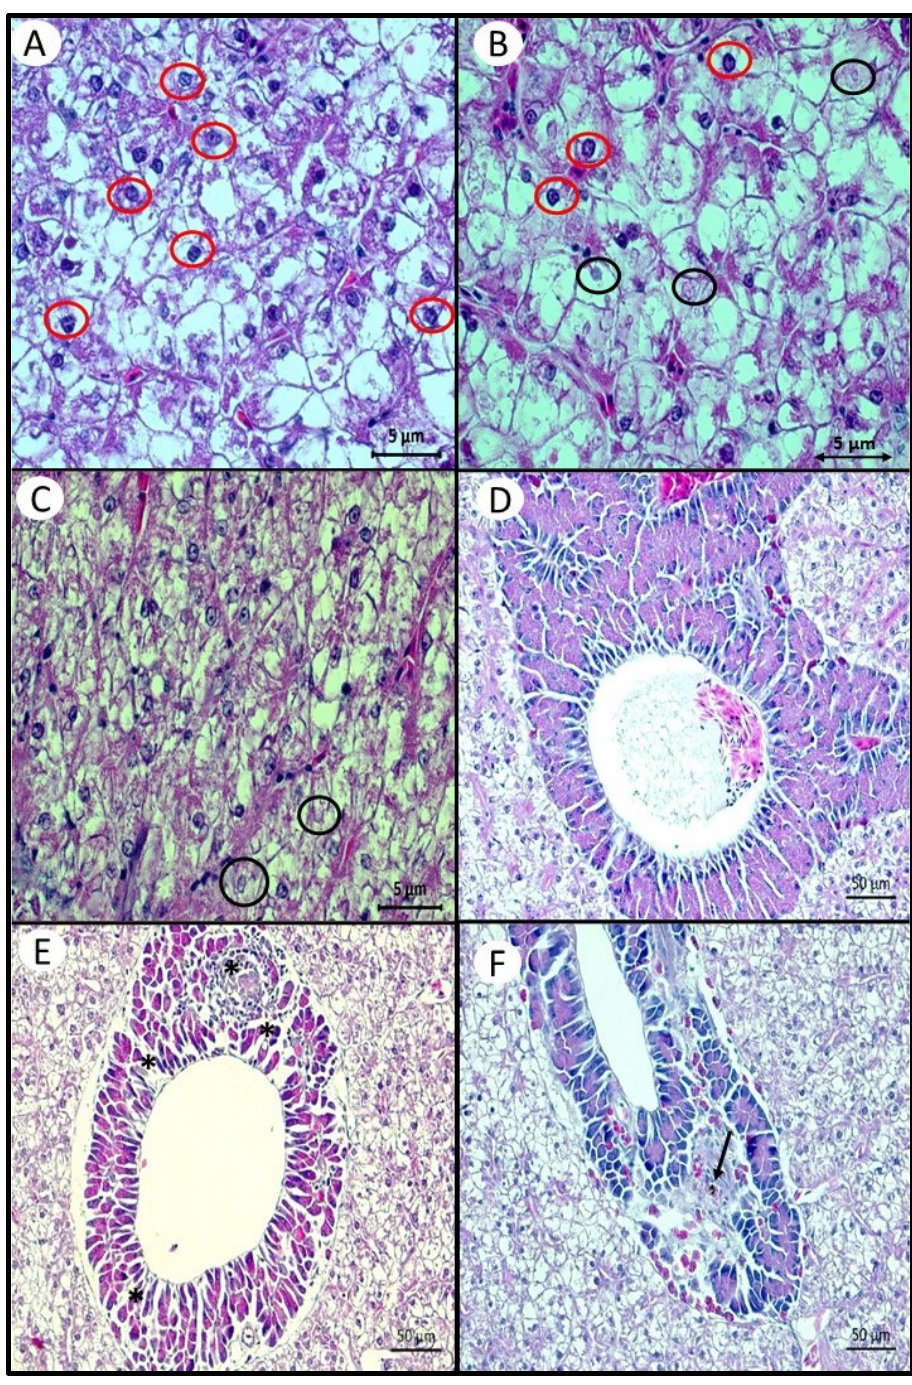
Figure 3. Histological changes in the hepatopancreas of Nile tilapia juveniles fed different levels of Aurantiochytriu m sp. meal (AM) or a cod liver oil (CLO) ‐ supplemented diet for 87 days, at 22 °C. ( A ) High intensity of nuclei with karyolysis (red circle) in fish fed the 20AM diet. ( B ) High intensity of nuclei with karyorrhexis (black circle) in fish fed the 40AM diet. Nuclei with karyolysis are indicated by red circles. ( C ) Lower intensity of nuclei with karyolysis and karyorrex in fish fed the 5AM diet. ( D ) Nuclei in pancreatic acini without alterations in fish fed the 0AM diet. ( E ) Loss of nuclei in pancreatic acini in fish fed the 5AM diet (alteration indicated by asterisks). ( F ) Macrophage with bilirubin in fish fed the CLO diet (alteration indicated by